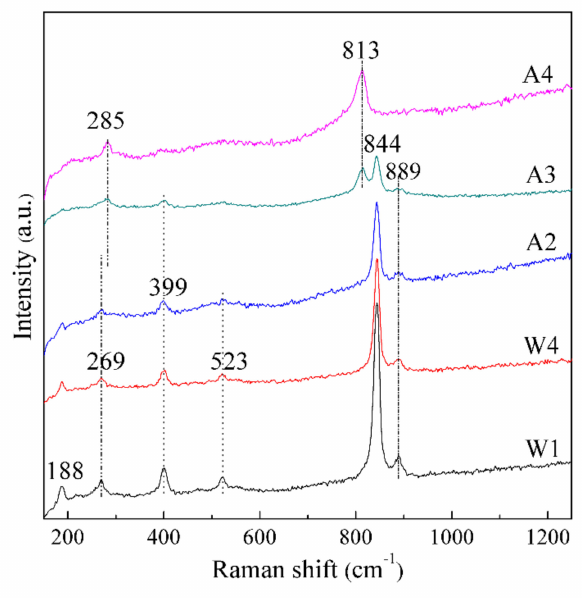
Figure 9. Raman spectra of the solid samples from washing natisite with water and sulfuric acid solutions.